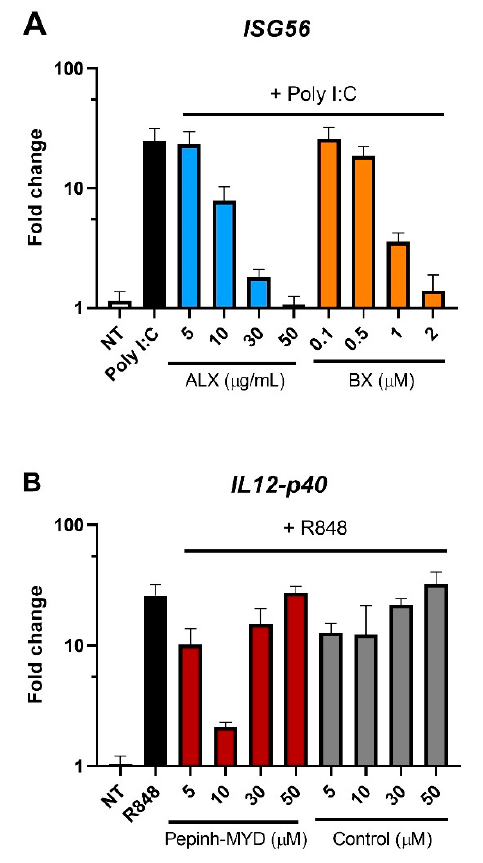
Figure A8. Assessment of the optimal concentration of RLR or MyD88 inhibitors in PBMCs. PBMCs from 3 healthy donors were pre-incubated with RLR inhibitors (ALX and BX) for 1 h ( A ) or with MyD88 inhibitor (Pepinh-MYD) and its peptide control (Control) for 6 h ( B ). Afterwards, the cells were treated for 24 h with Poly I:C (0.5 μ g/mL) or R848 (10 μ g/mL). Following stimulation, the cells were lysed and changes in gene expression were analyzed by RT-qPCR.